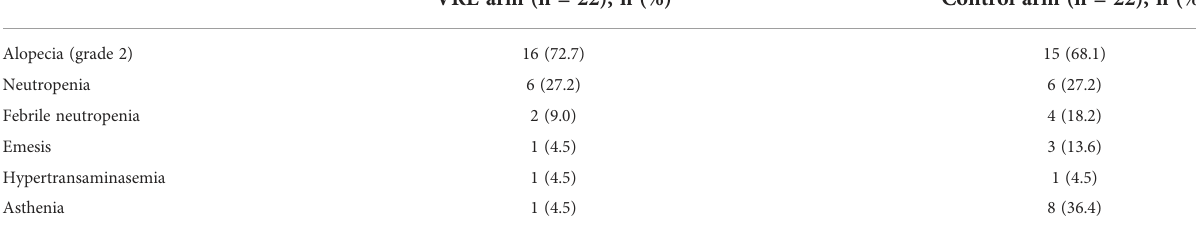
TABLE 3 Grade 3 and 4 reported